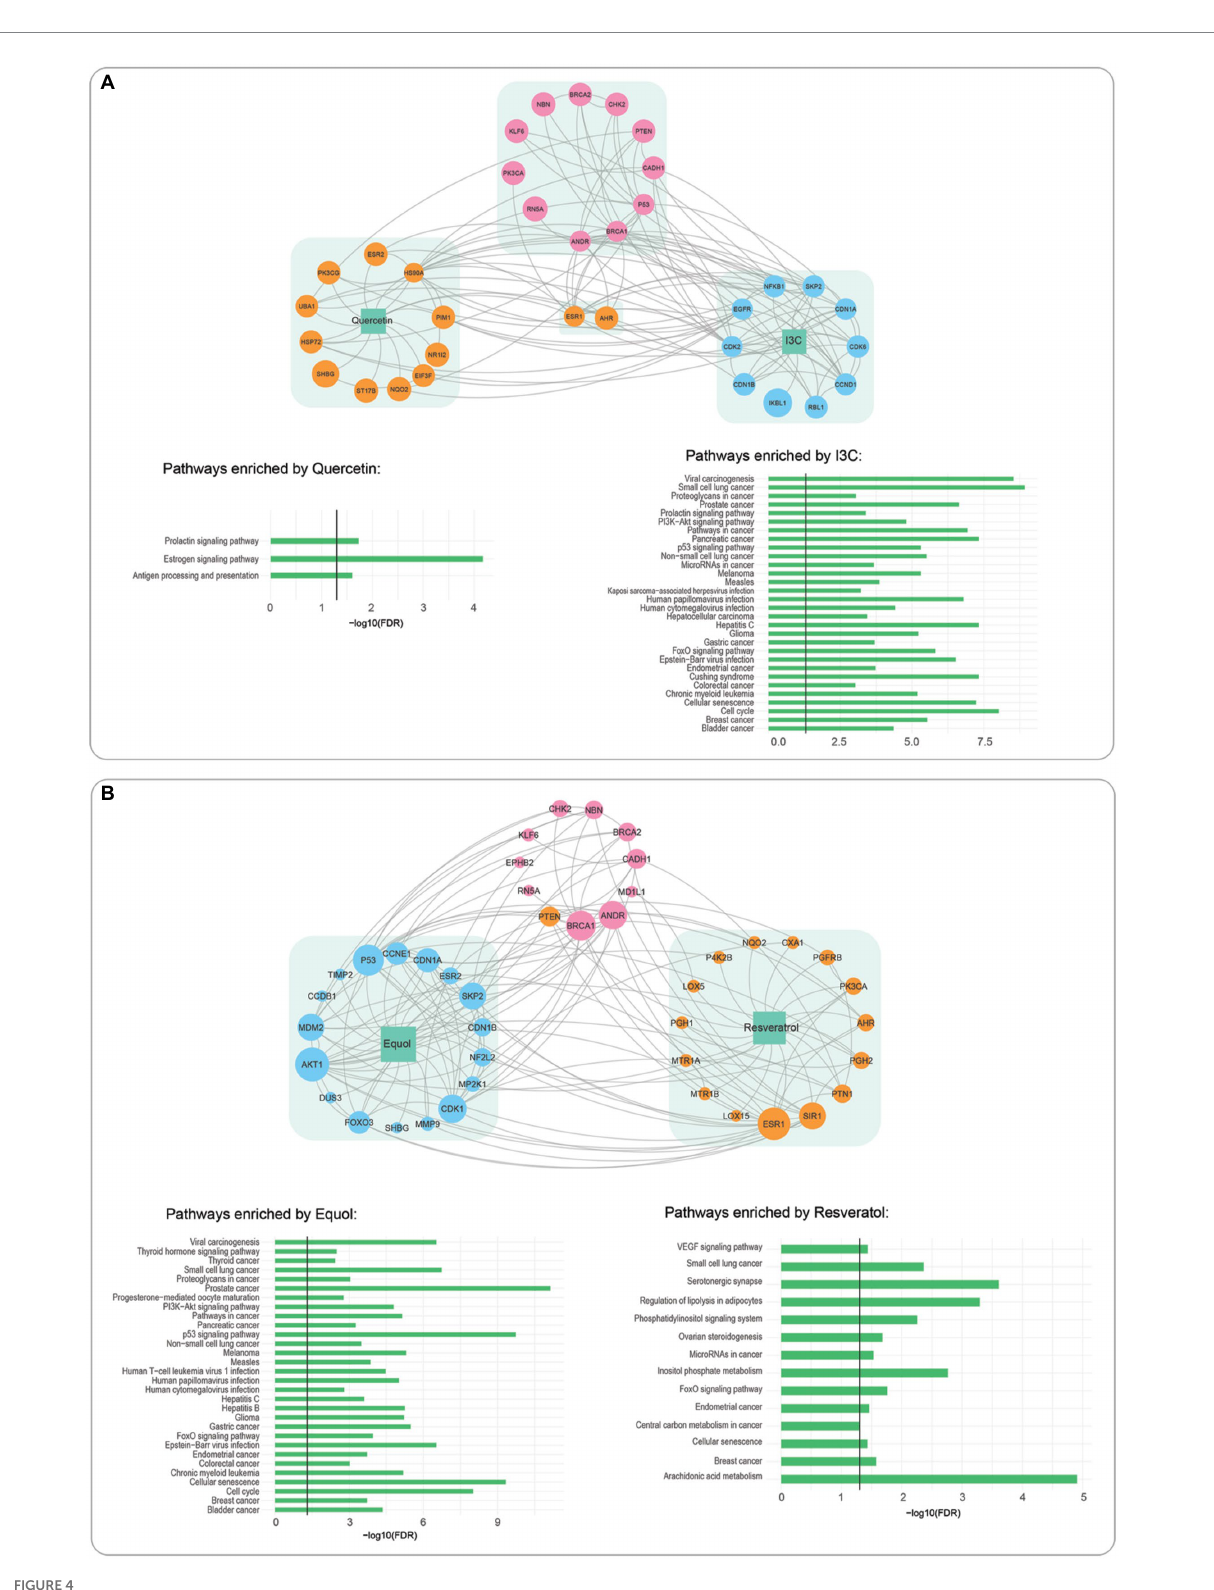
FIGURE 4 Interactions of phytochemical interactome with prostate cancer driver proteins and pathway enrichment analysis. (A) I3C interactome (blue), quercetin interactome, (orange). (B) Equol (blue) resveratrol (orange). Linkages to prostate cancer interactome (pink) are indicated by grey lines, Bar graphs indicate pathways significantly enriched by each